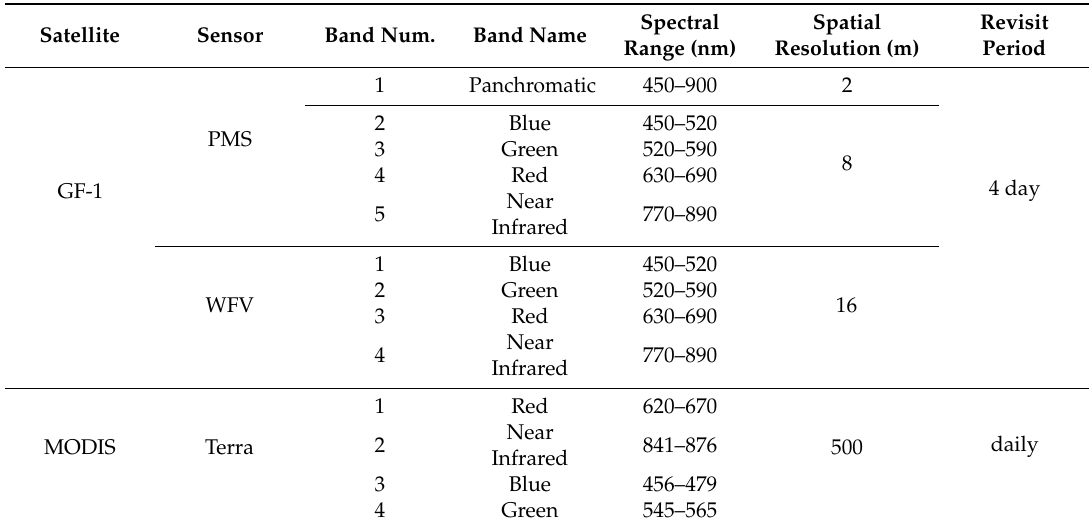
Table 1. Specification of spectral bands of Chinese GF-1 and MODO9GA